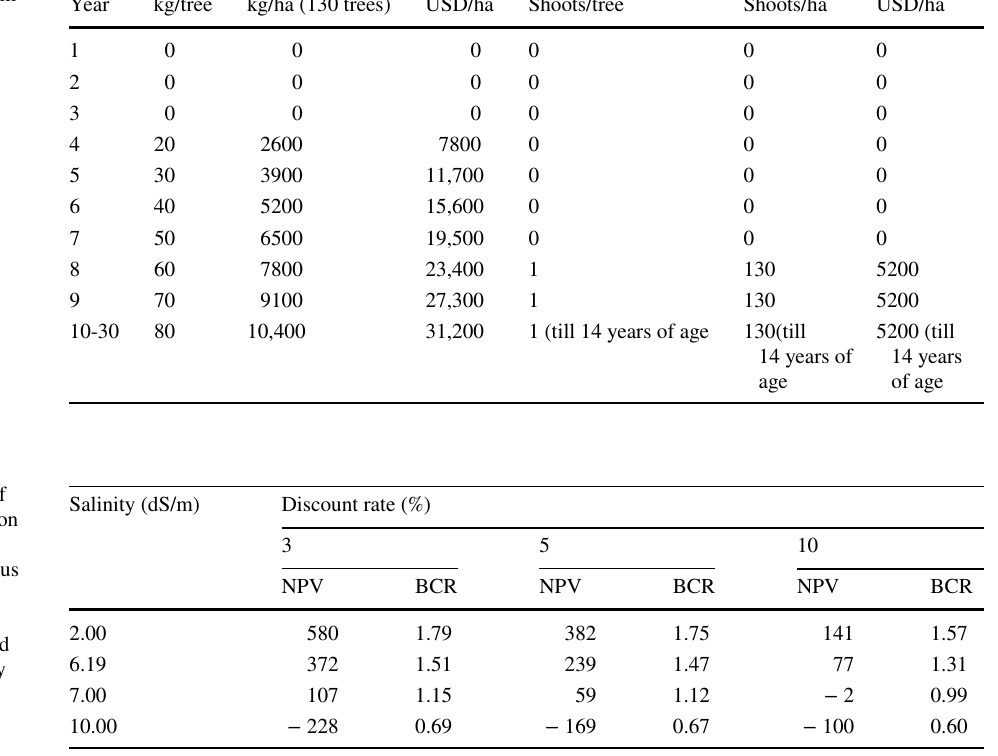
cultivation over the years